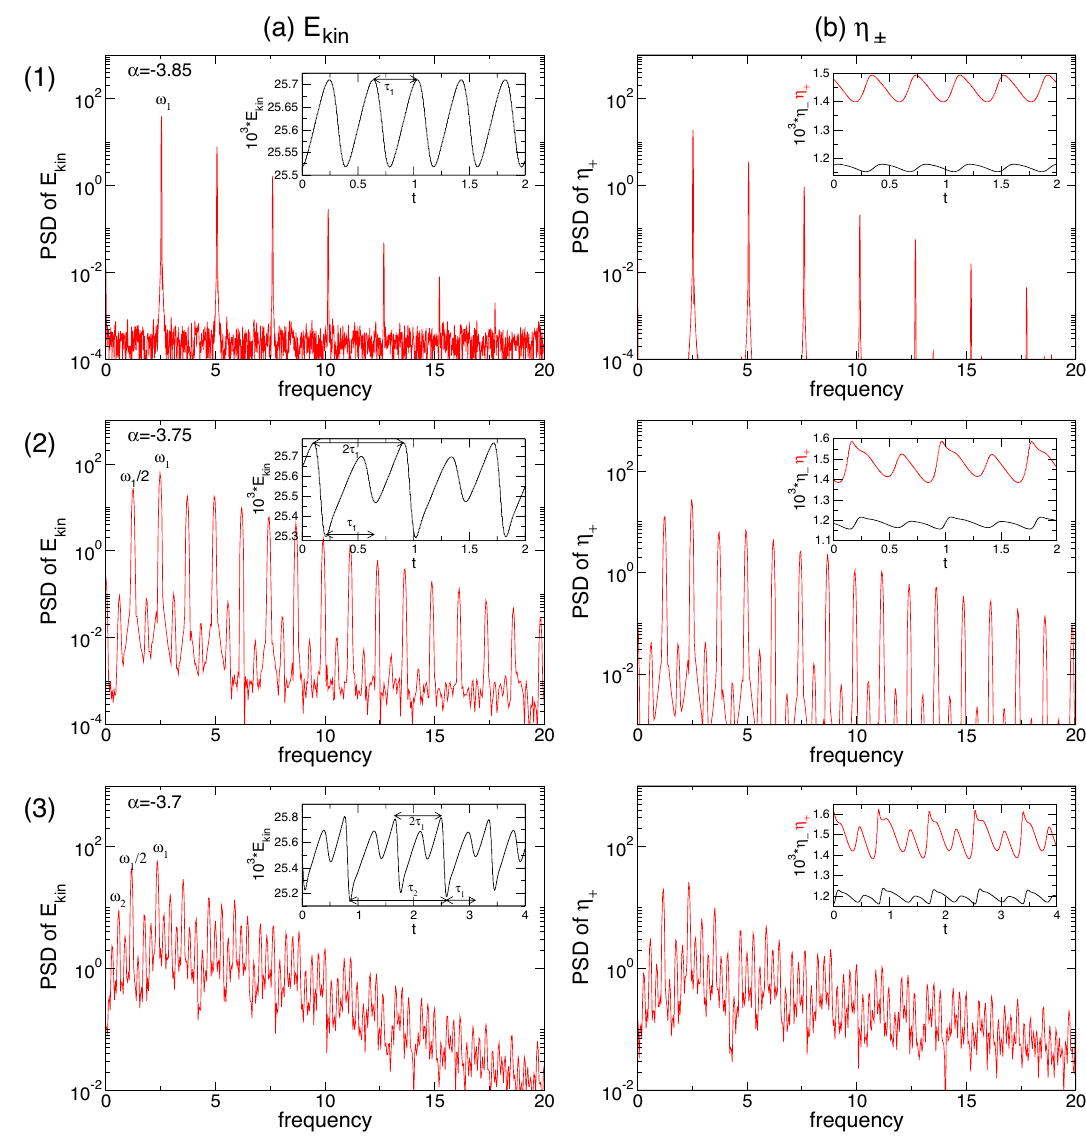
Figure 6. Time series and power spectral densities (PSDs) of the pulsating flow twin-pair state, T2 puls , for different α . PSDs of ( a ) E kin and ( b ) η corresponding frequency ω 1 with corresponding frequency ω 1 / 2 corresponding frequency ω 2